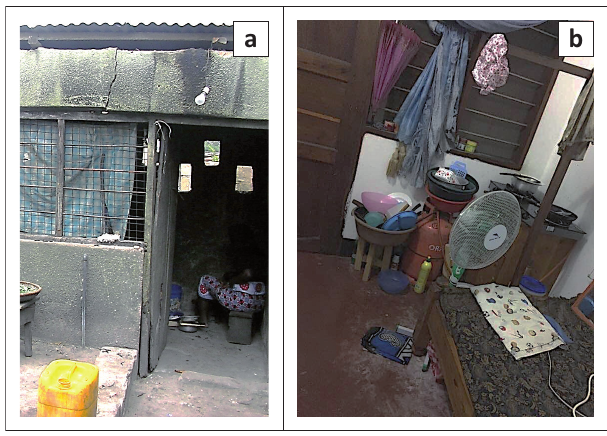
FIGURE 4: (a) Indoor cooking in a confined space increasing fire exposure. (b) Indoor cooking in undesignated and congested space increasing fire exposure.